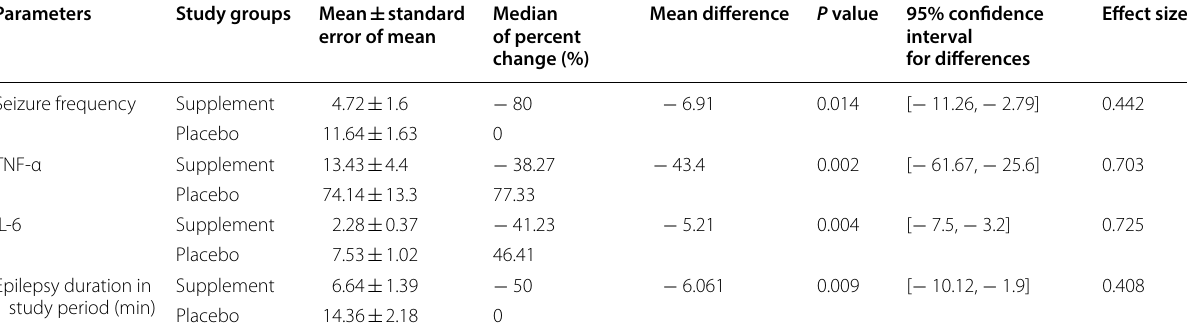
All results are based on Bootstrapping Method; Effect size conventions; f